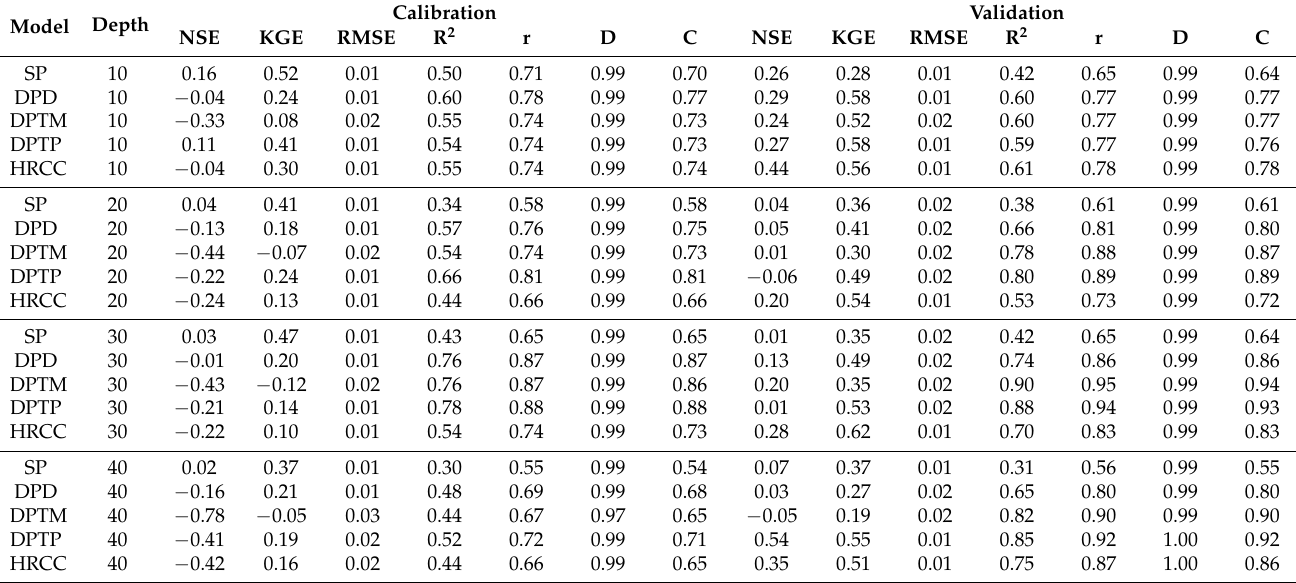
Table 6. Statistics of the model adjustments for the hydraulic data measured in the BR-CST tower. Model